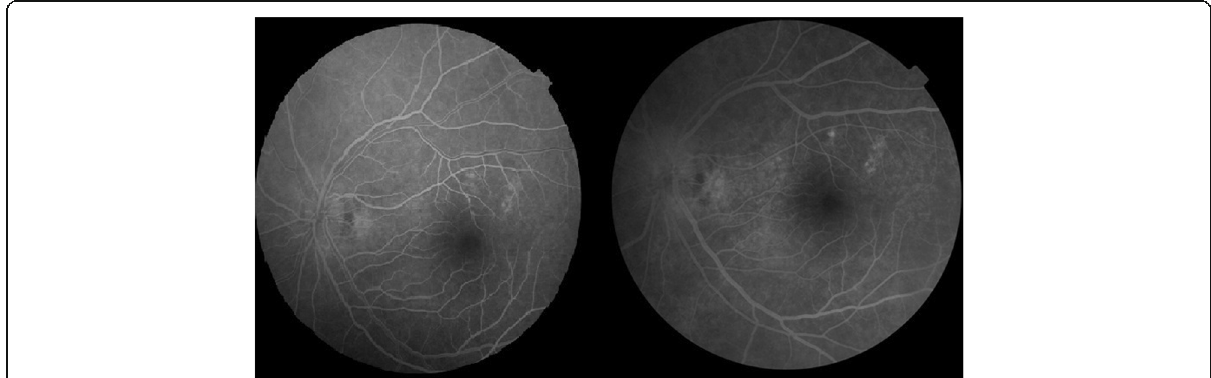
Fig. 9 Day 56 Fluorescein angiogram, early venous (left) and recirculation (right) phases, demonstrates non-specific parafoveal staining superiorly, with no overt delays, evidence of vasculitis, macular edema nor